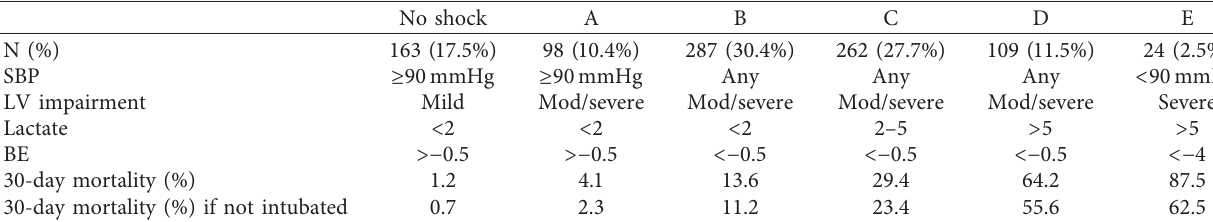
Table 2: Frontline SAVE ACS classification.